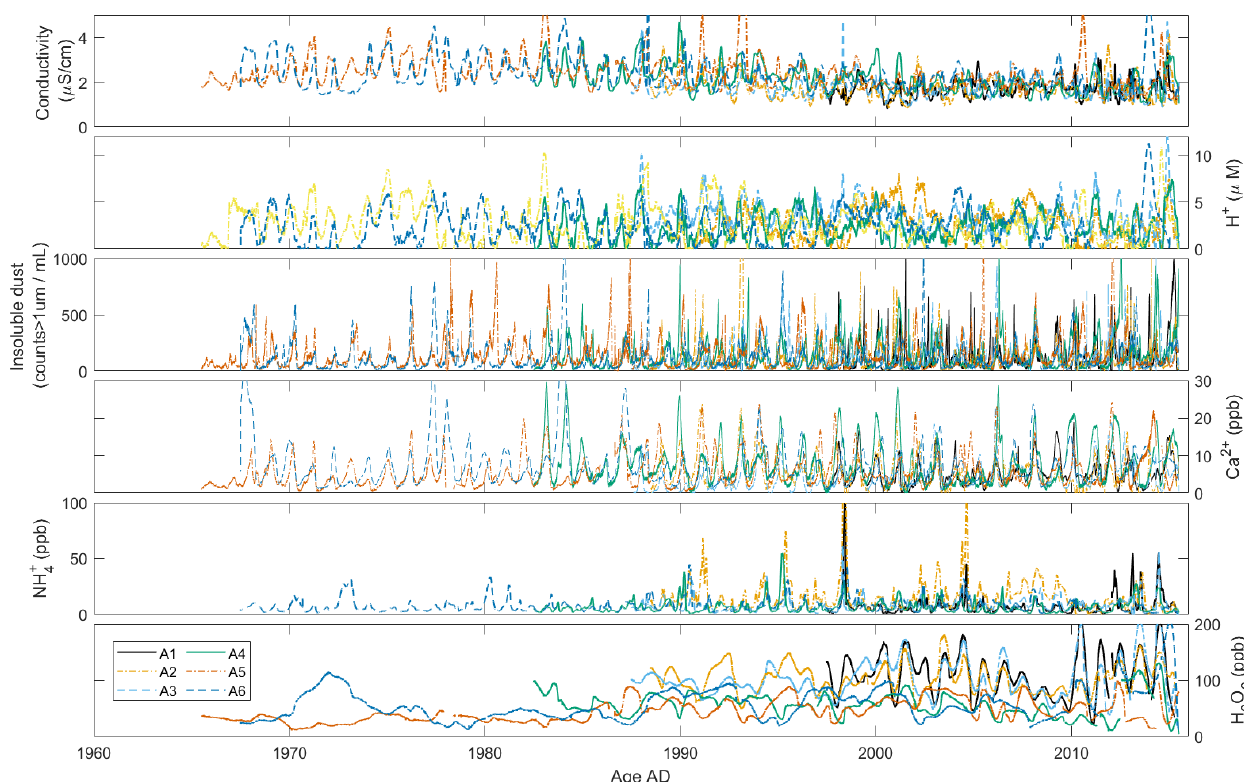
Figure 2. Proxies measured by means of CFA in the six shallow firn cores: T2015-A1 (black), T2015-A2 (dashed yellow), T2015-A3 (light blue), T2015-A4 (green), T2015-A5 (dashed orange) and T2015-A6 (dashed dark blue). From top to bottom, the following variables are shown: conductivity, acidity, insoluble dust, Ca 2 + , NH + and H 2 O 2 concentrations. Note that the acidity for T2015-A1 and the NH + 4 T2015-A5 were not of sufficient quality and are consequently not